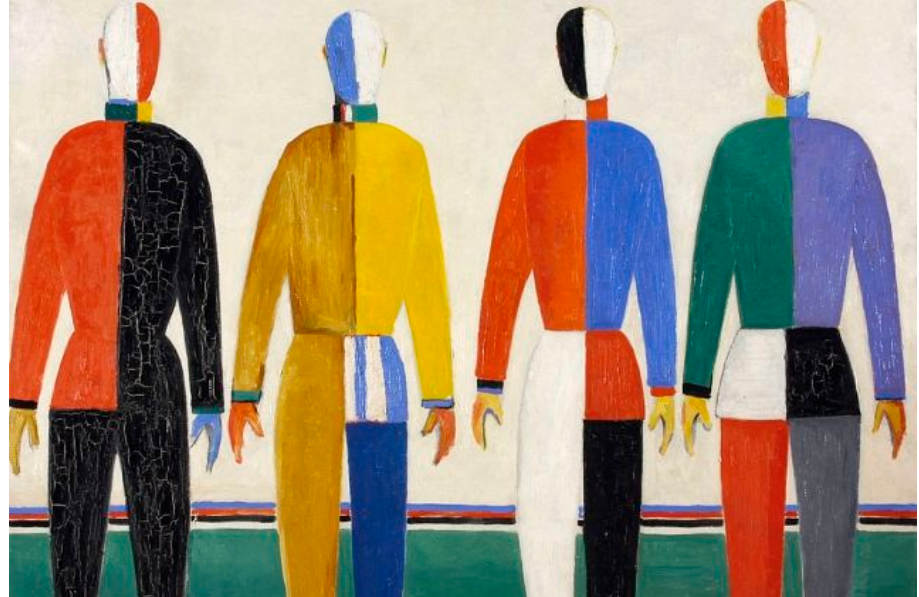
Figure 1. Kazimir Malevich. Four peasants.